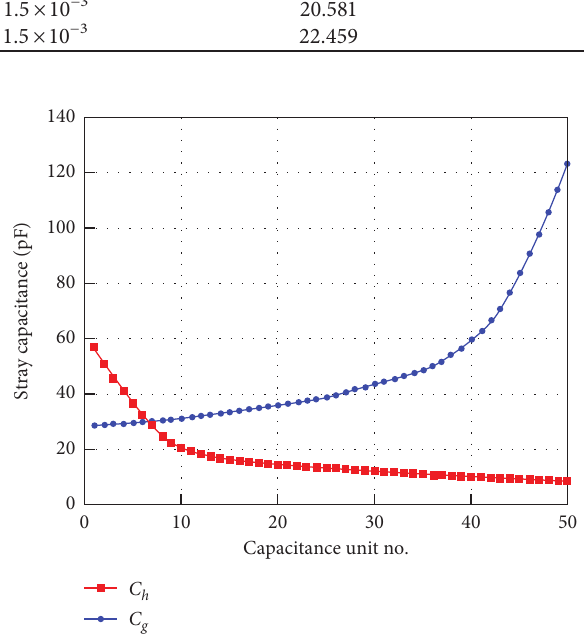
Figure 6: Distributions of C